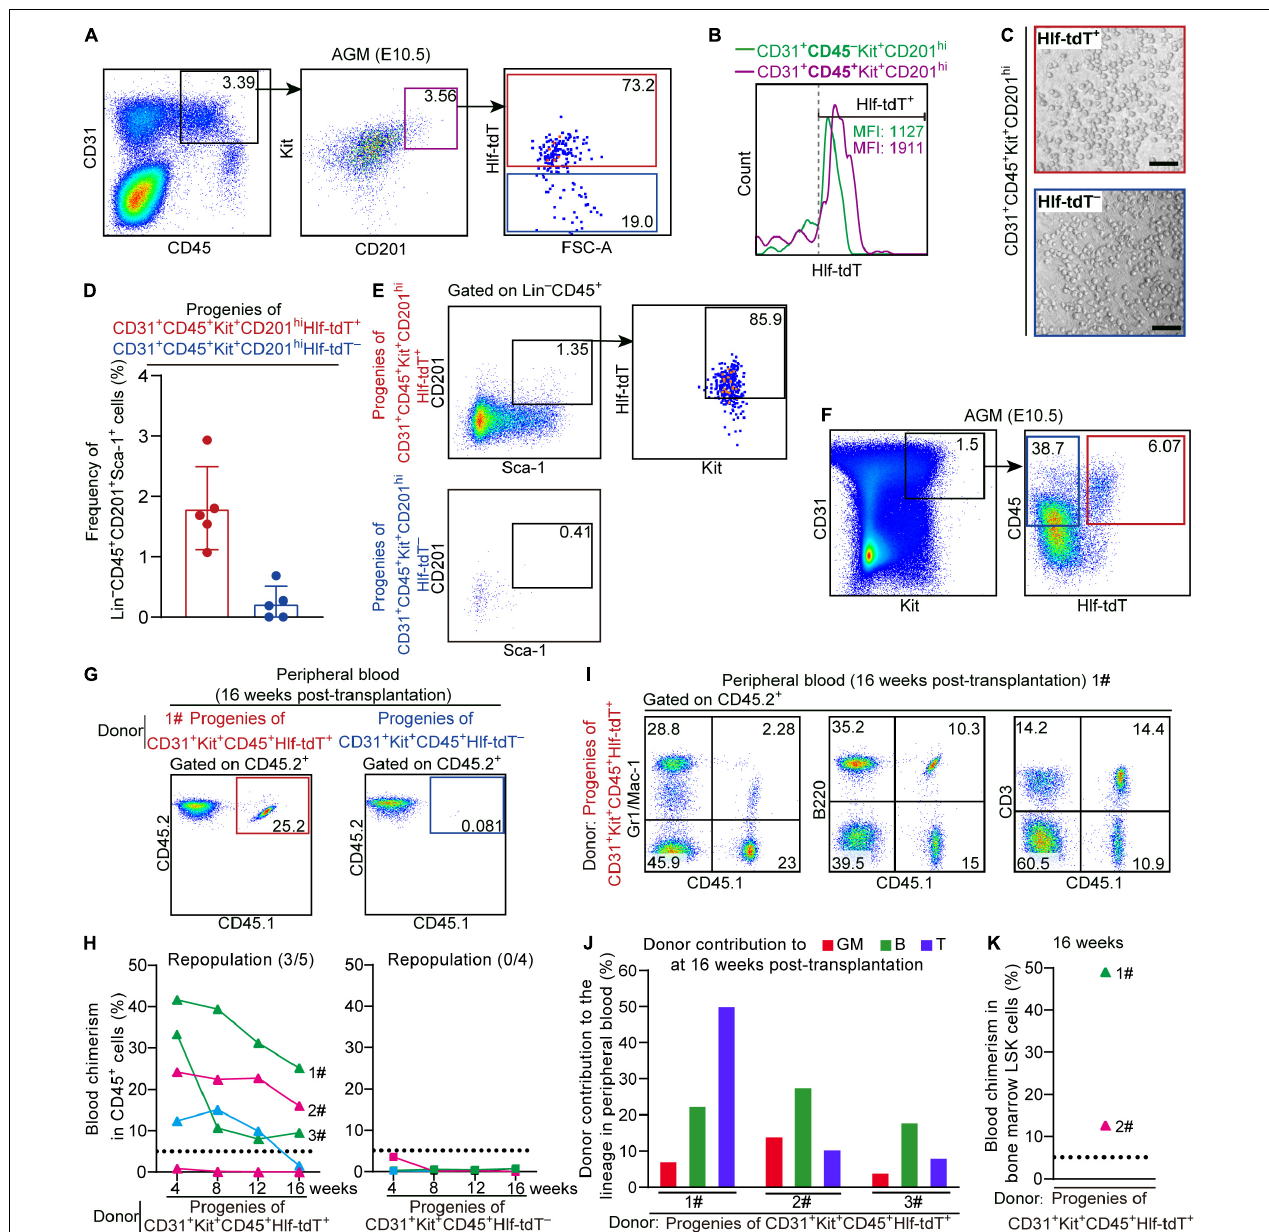
FIGURE 3 | Hlf-tdTomato enriches functional CD45 + pre-HSCs in the E10.5 AGM region. (A) Representative FACS plots showing the proportion of Hlf-tdTomato + and Hlf-tdTomato − cells in the CD31 + CD45 + Kit + CD201 hi population in the AGM region of E10.5 Hlf-tdTomato embryos. Data are representative of five independent experiments. (B) Representative FACS histogram showing the fluorescence intensity of tdTomato in the CD31 + CD45 − Kit + CD201 hi and CD31 + CD45 + Kit + CD201 hi populations in the AGM region of E10.5 Hlf-tdTomato embryos. Values of mean fluorescence intensity of tdTomato in the Hlf-tdTomato + cells are indicated. Data are representative of five independent experiments. (C) Representative morphology of hematopoietic cells generated from Hlf-tdTomato + cells and Hlf-tdTomato − cells within the CD31 + CD45 + Kit + CD201 hi population. Scale bar, 100 µ m. (D) Graph showing the frequency of Lin − CD45 + CD201 + Sca-1 + cells generated from the indicated populations from the E10.5 AGM region after co-culture measured by FACS analysis. Data are shown as means ± SEM from five independent experiments. (E) Representative FACS plots showing the expression of Hlf-tdTomato and Kit in Lin − CD45 + CD201 + Sca-1 + cells that are generated from the indicated populations of the E10.5 AGM region after co-culture. Data are representative of five independent experiments. (F) Cell sorting strategy for the populations from the AGM region of E10.5 Hlf-tdTomato embryos for co-culture/transplantation assay. The cell populations sorted for functional assay are denoted by colored boxes. (G) Representative FACS plots of blood chimerism of donor-derived (CD45.1 + CD45.2 + ) cells in CD45 + cells at 16 weeks post-transplantation. (H) Graphs showing the blood chimerism in CD45 + cells of each of all the recipients from 4 to 16 weeks post-transplantation. The recipients were transplanted with the culture products of CD31 + Kit + CD45 + Hlf-tdTomato + (triangle, left) or CD31 + Kit + CD45 + Hlf-tdTomato − (square, right) cells from the AGM region of E10.5 Hlf-tdTomato embryos. Numbers of repopulated/total recipients are shown in the brackets. For each transplantation assay, cells from